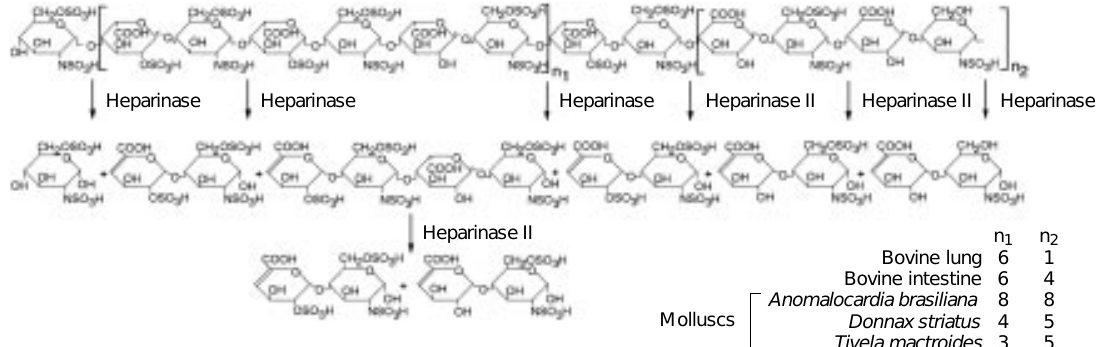
Figure 9 - Proposed structure of heparin in mammals and